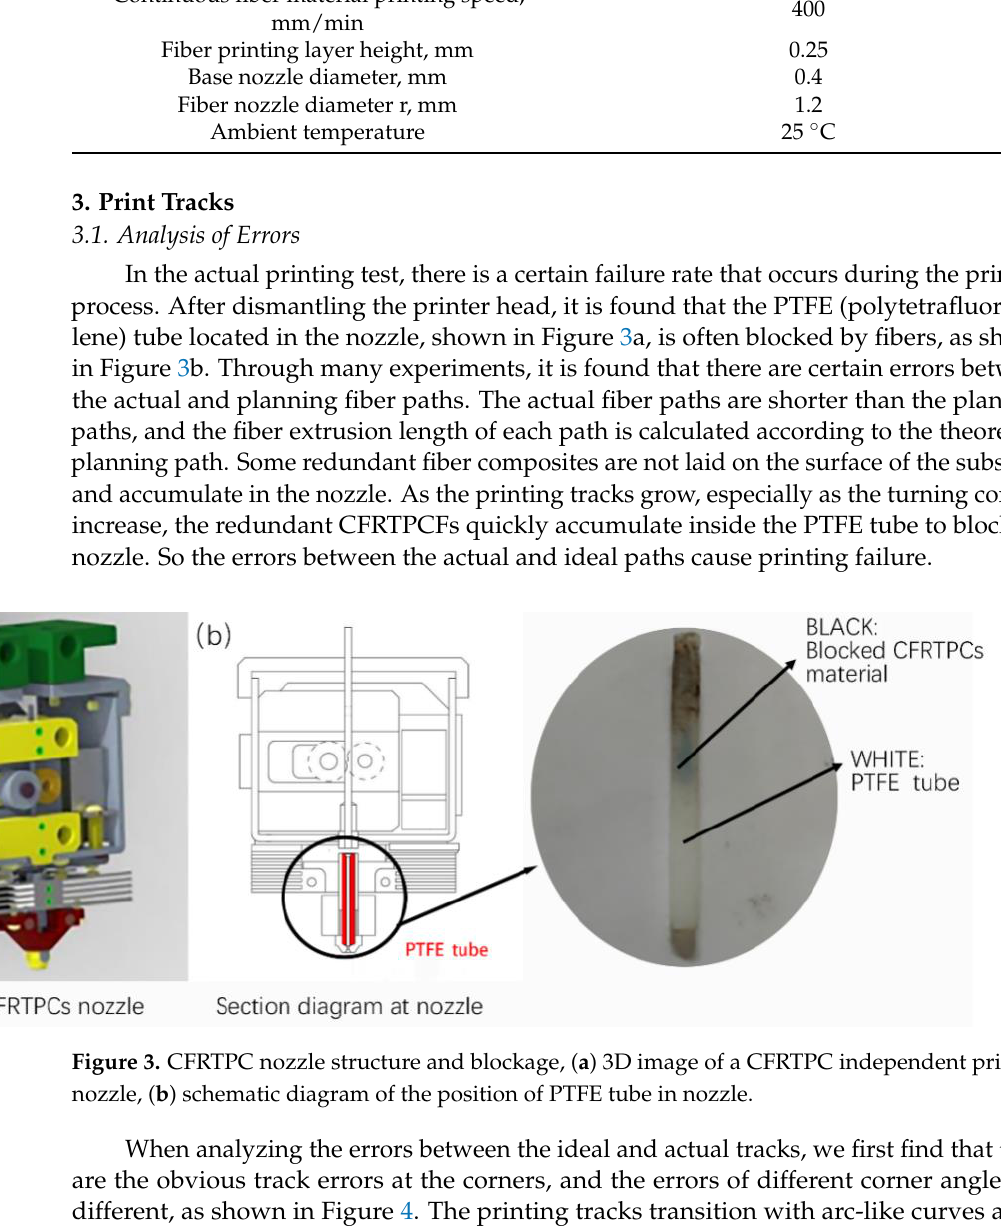
Figure 4. Printing with different corner angles, ( a ) 30°, ( b ) 60°, ( c ) 90°, ( d ) 120°. White: CGFRF/PLA. Black: PLA. Red: extracted CGFRF trace lines. Green: ideal tracks.